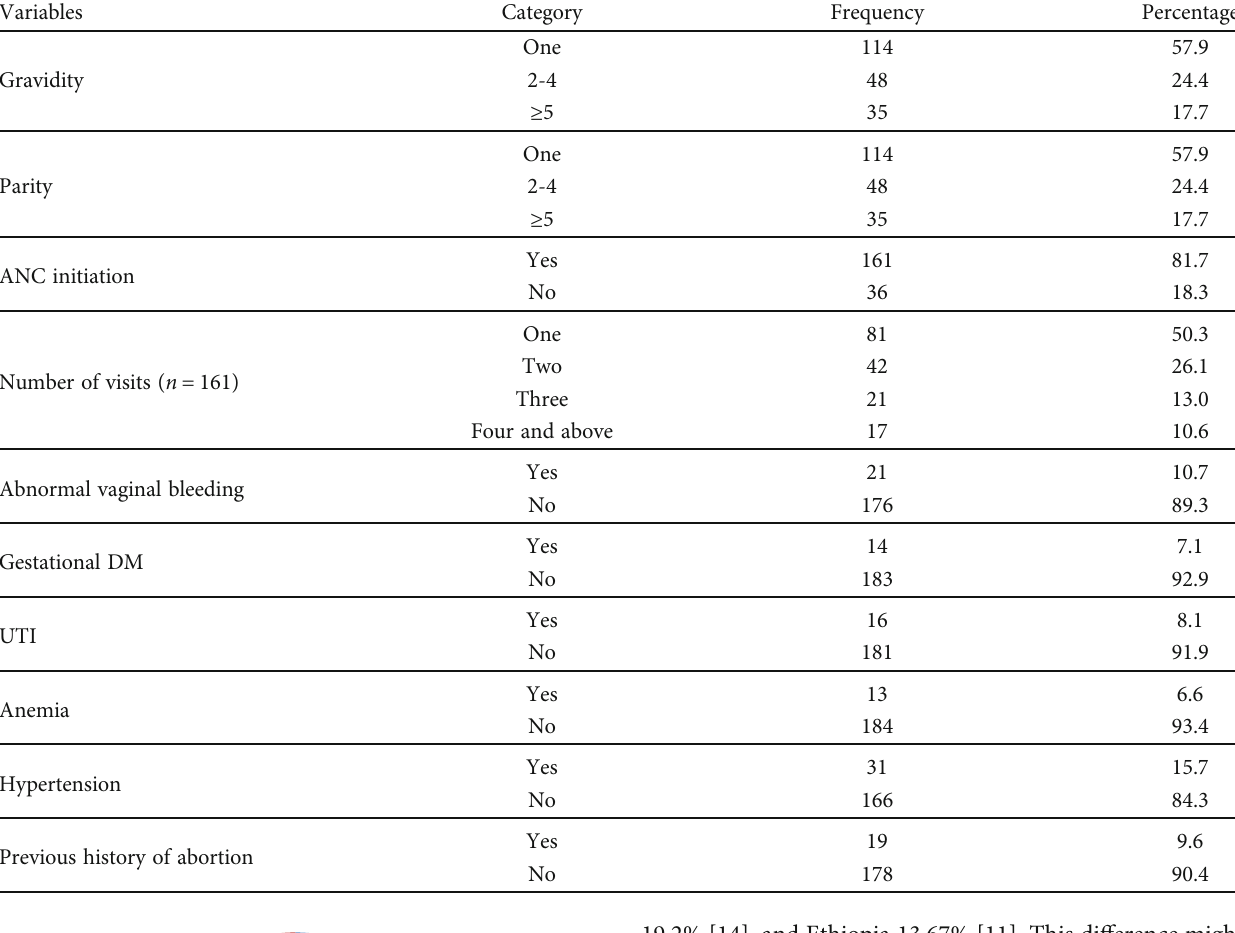
Table 2: Obstetric-related characteristics of the pregnant women in Wolkite comprehensive specialized hospital, Gurage zone, southern Ethiopia, 2021.